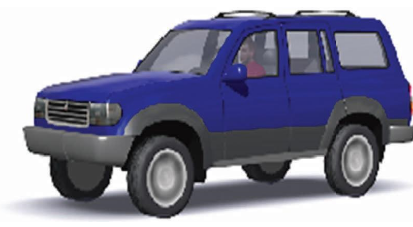
Figure 4: E-class SUV. Table 3: Specifcations of E-class SUV.